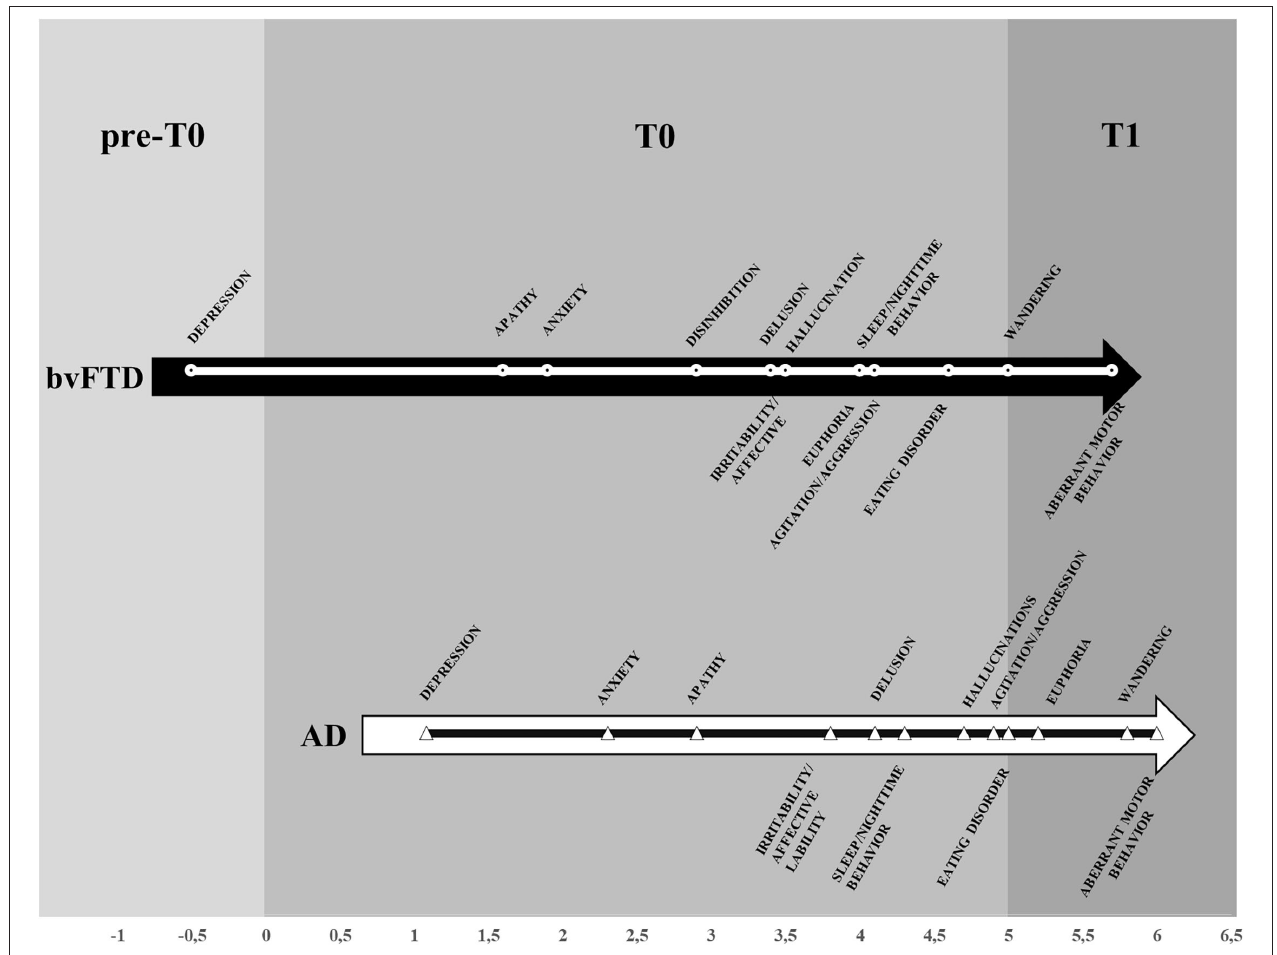
FIGURE 1 | Prevalence of BPSD in AD and bvFTD